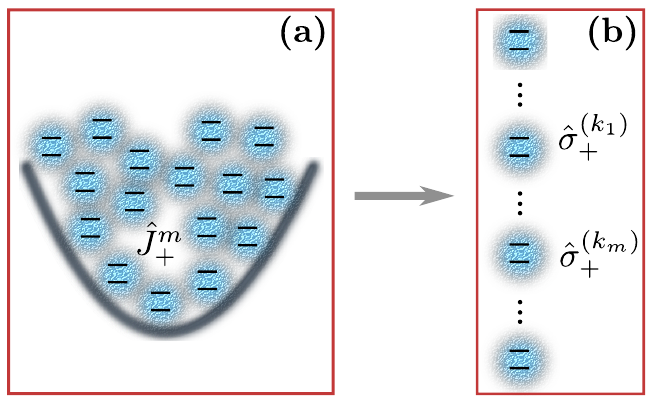
Figure 1: The test of Bell correlations in a bosonic systems. When (a): the qubits cannot be addressed individually, the Bell correlations are detected by means of a collective operator ˆ J + , which is replaced by local operators ˆ σ are spatially